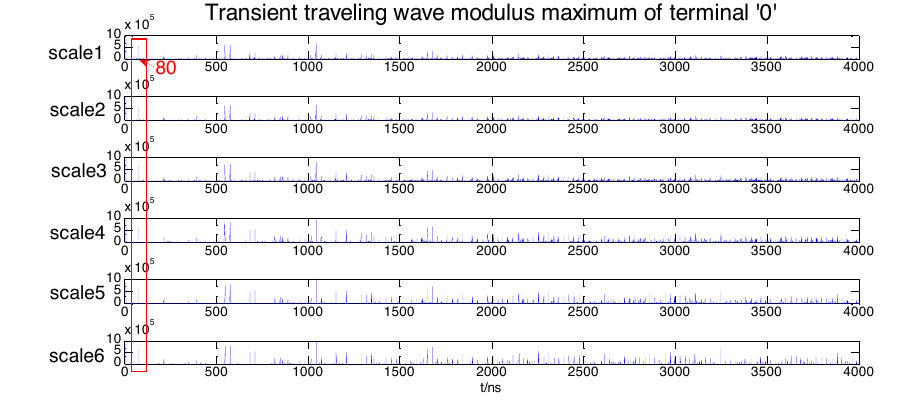
Fig. A2. Transient traveling wave modulus maximum of terminal